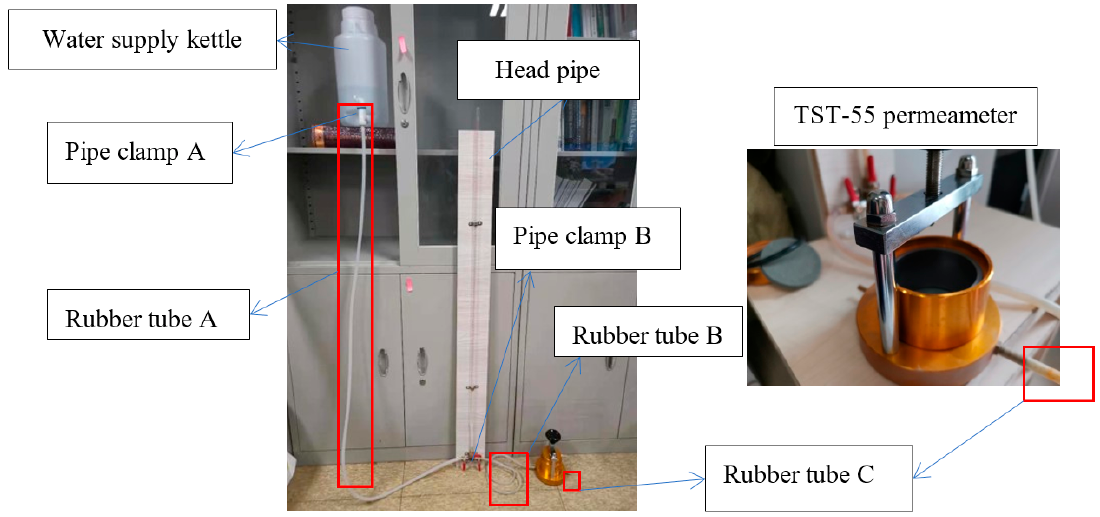
Figure 4. Permeability coefficient measurement experiment.